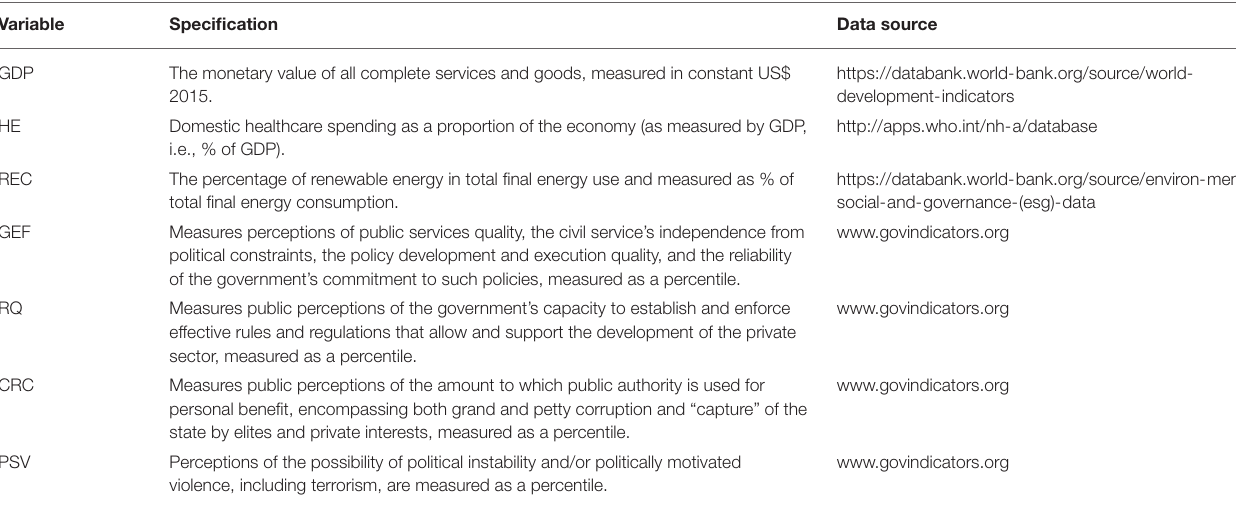
TABLE 2 | Variables specification and data source.